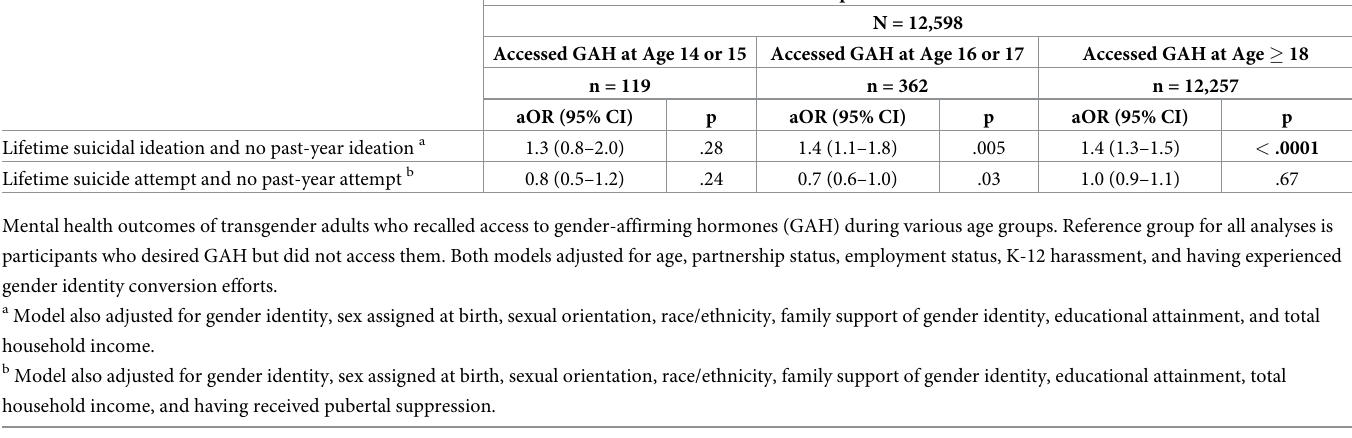
Table 5. Lifetime but no past-year suicide ideation and attempts for participants who accessed gender-affirming hormones (estrogen or testosterone).